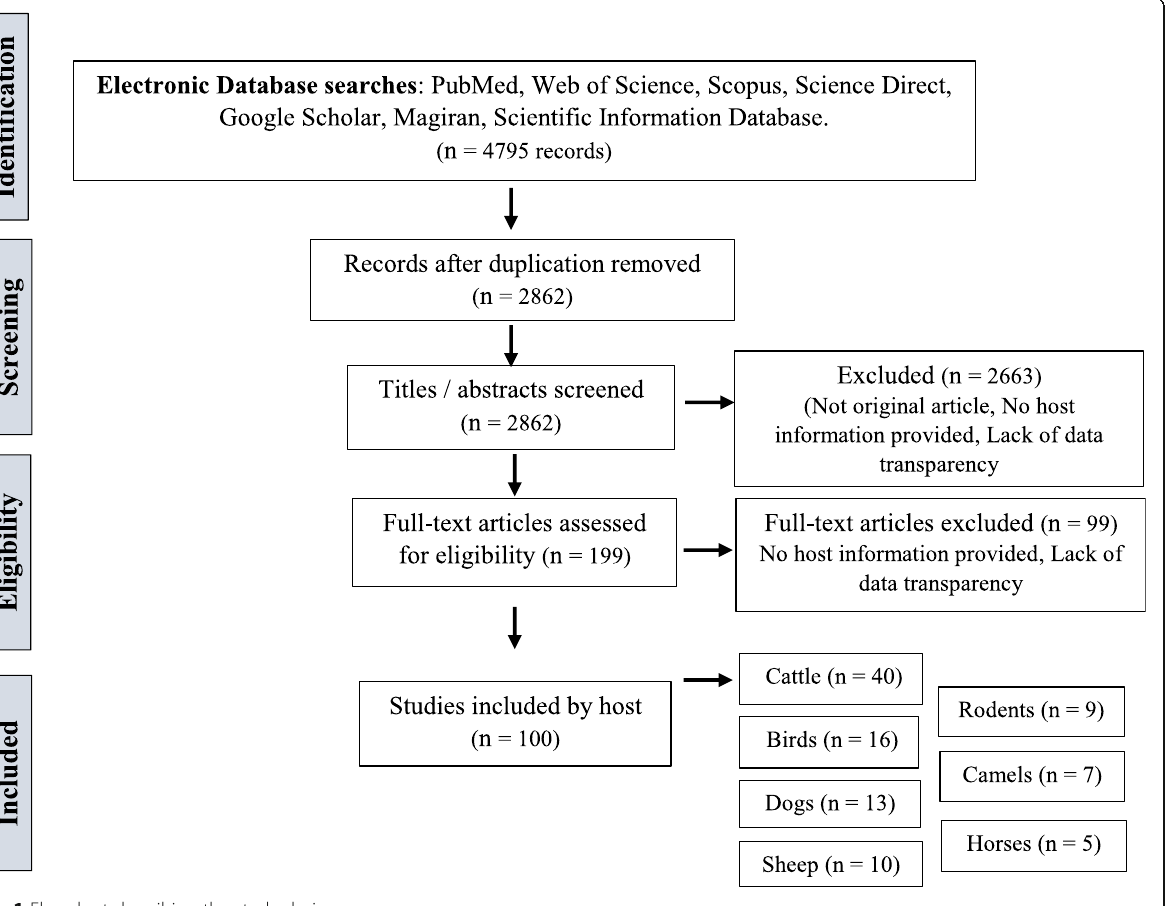
Fig. 1 Flowchart describing the study design